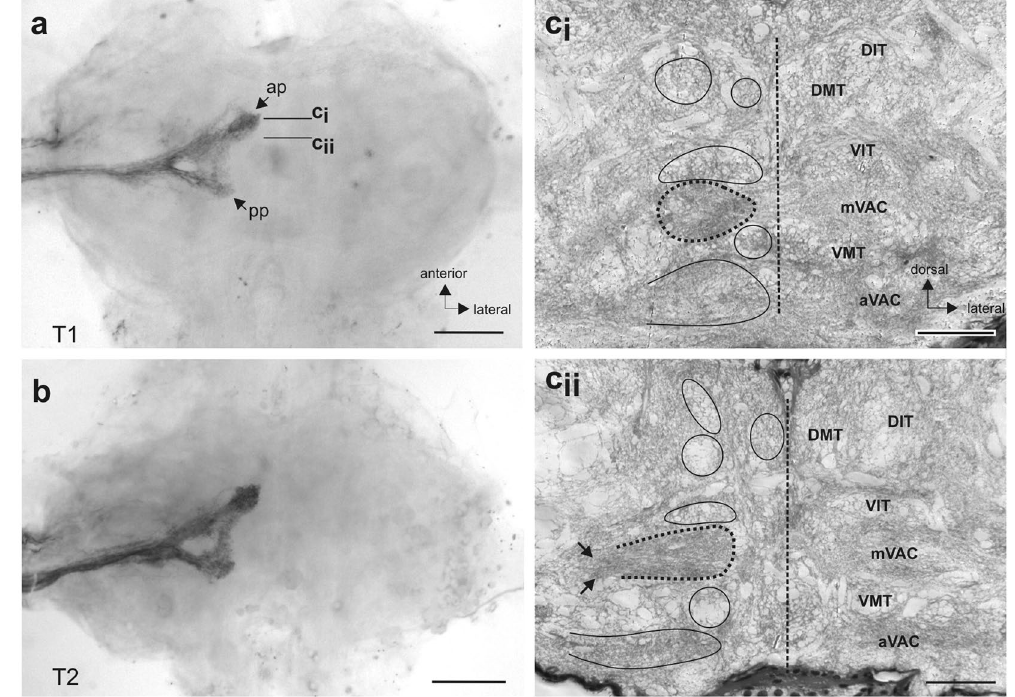
Figure 8. Central projection of the complex tibial organ afferents. Staining of sensory afferents in N5B1 in the ( a ) prothoracic ganglion and ( b ) mesothoracic ganglion. Afferents terminate on the ipsilateral side in anterior and posterior projections (ap/pp). (ci–ii) Histological sections of the prothoracic ganglion locate the afferents in the main mechanosensory neuropil, the mVAC (indicated by dotted circle). Sections show the main neuropils and tracts (encircled) in the ganglion. Levels of sections are indicated in ( a ). Arrows in (cii) indicate the bundle of fibres entering the mVAC. Abbreviations: ap, anterior projection; aVAC, anterior ventral association centre; DIT, dorsal intermediate tract; DMT, dorsal median tract; mVAC, median ventral association centre;pp, posterior projection; T1, prothoracic ganglion; T2, mesothoracic ganglion;VIT, ventral intermediate tract; VMT, ventral median tract. Scales: ( a , b ) = 200 µ m; ( c , d ) = 100 µ